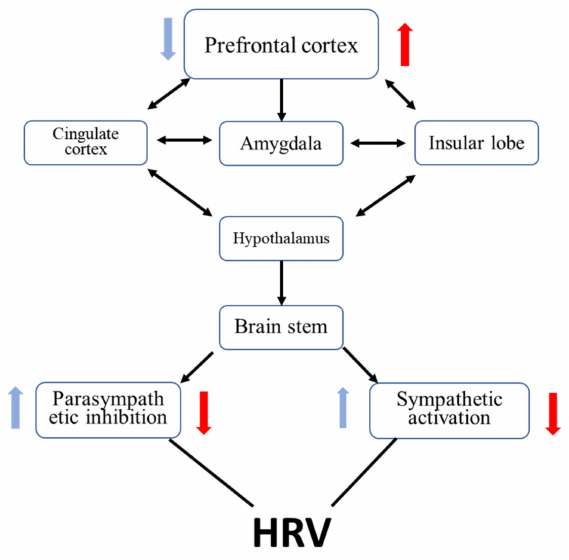
Figure 5. The path of action of tPCS on